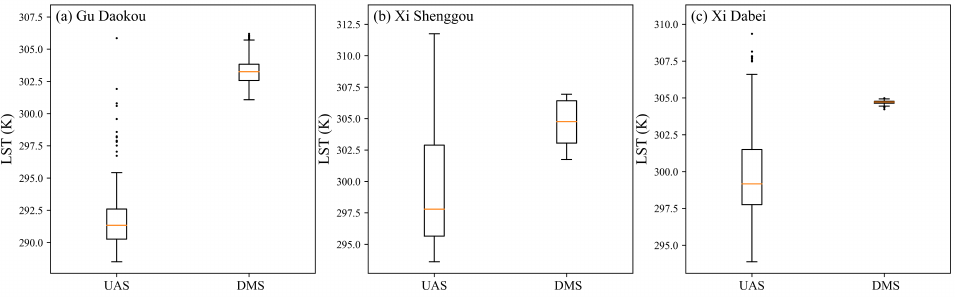
Figure 6. Boxpltos of UAS aggregated LST and DMS downscaled LST at three flight sites.